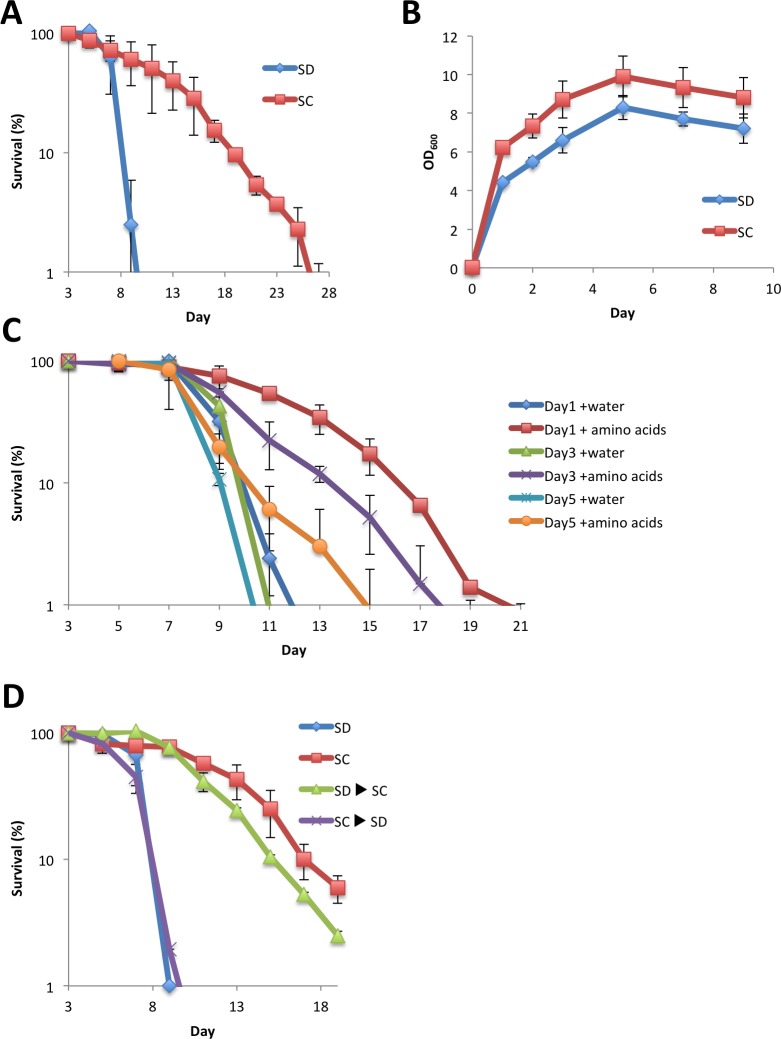
Addition of non-essential amino acids extended the chronological lifespan of a prototrophic yeast strain.(A), (B) Chronological lifespan and cell growth in a synthetic medium with or without amino acids. YOM36 cells grown in SD medium were transferred to SD or SC media and CFUs and cell density of the cultures were measured at the indicated times. (C) Effect of late addition of amino acids. Amino acid mixture or water was added to cultures of YOM36 cells grown in SD for the indicated times and chronological lifespan assay was performed as in (A). (D) Effect of media swap on chronological lifespan. The original media of the cells grown as in (A) and (B) were swapped at day 3. Error bars represent the means ± SD (n = 3). (A) P<0.01; (B) P<0.01; (C) P<0.01 (Day 1 water vs Day 1 amino acids; Day3 water vs Day 3 amino acids), P<0.05 (Day 5 water vs Day 5 amino acids); (D) P<0.01 (SD vs SD→SC; SC vs SC→SD).